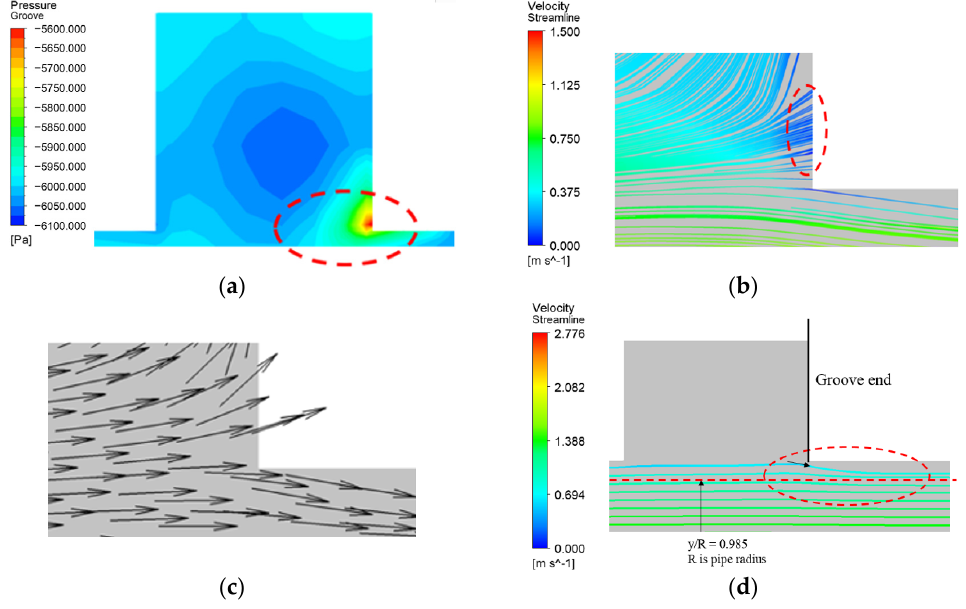
Figure 12. High-pressure region on groove corner. ( a ) the pressure contour at the groove, ( b ) the streamline at the lower right corner of the groove, ( c ) the velocity vector near the groove, and ( d ) the streamline of the main flow. Therefore, the velocity distribution of the main flow will be different due to the max- imum negative v -velocity. Figure 13a–c are the main flow velocity distributions at the end of the groove for w / k = 0.5, 1.0, and 1.5, respectively, and (d) is an enlarged figure of w / k = 1.5. When comparing the velocity distribution at the end of the 5th and 6th groove, there is no difference in the velocity distribution. However, when comparing the 5th and 25th velocity distributions, the main flow velocity profile increases when y/R < 0.811 and de- creases the range of 0.811 < y/R. This means that when passing through a single groove, the deformation of the main flow is small because the maximum negative v -velocity is lower after the collision. However, the flow after the collision still affects the main flow. Thus, this effect cannot be ignored if the number of grooves increases. ( a )